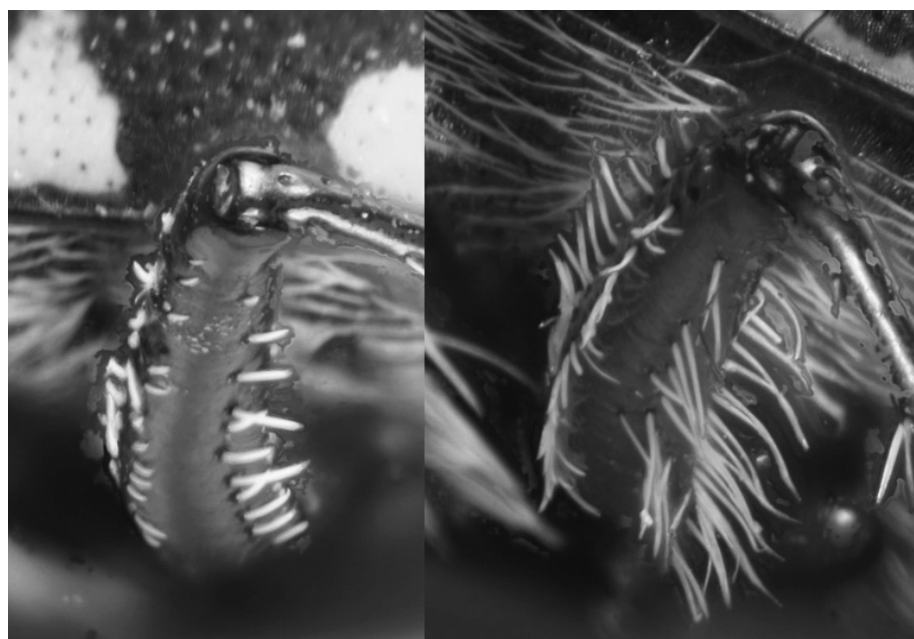
Figure 49. Metafemora, lateral view on lower side: C. aulica (left), C. aulicoides (right)